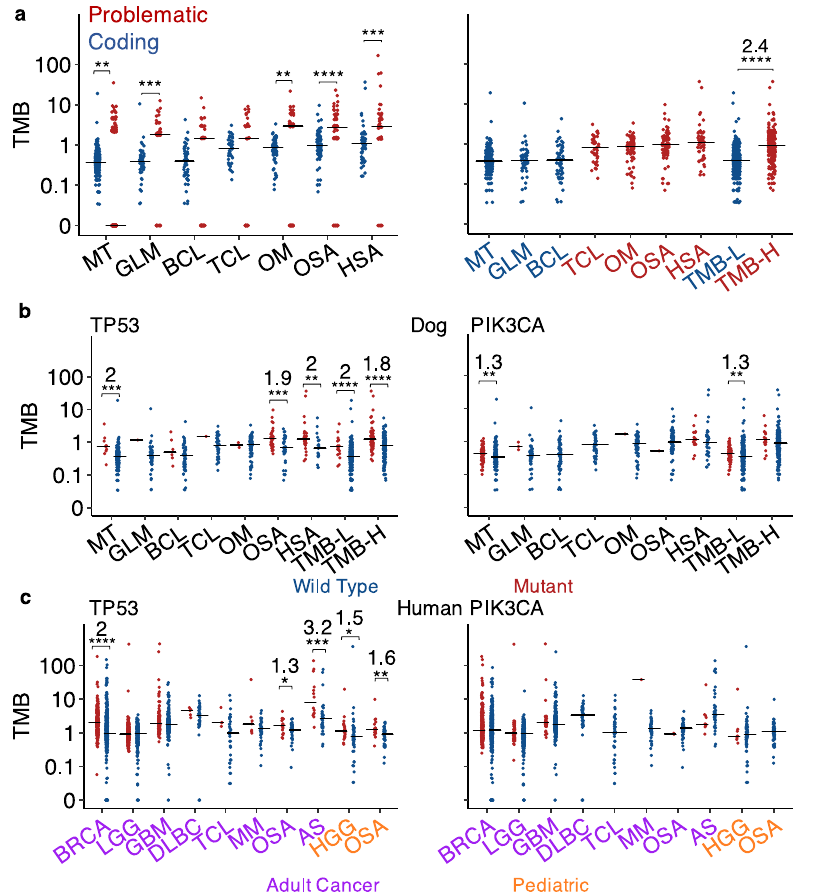
Fig. 6 TMB varies among tumor types and is correlated with TP53 mutation. a TMB distributions of each canine tumor type ordered left to right from lowest to highest median values. The left plot shows that problematic genes (see “ Methods ” ) have signi fi cantly higher TMB than other genes, and thus were excluded from further analyses. The right plot indicates that canine tumors are classi fi ed into TMB-low (TMB-L) and -high (TMB-H). Two-sided Wilcoxon tests were conducted to examine the TMB difference between two groups indicated, with **, ***, **, ****, ***, and **** from left to right representing unadjusted p = 0.006, 0.0006, 0.001, 4.7e − 6, 0.0003 and 2e − 16, respectively. For signi fi cant comparisons, the fold change in median TMB is also indicated. n = 202, 49, 55, 38, 71, 78, 49, 306 and 236 independent tumors for each tumor type listed from left to right, respectively. b , c TMB distributions of cases with wild type (blue) or mutant (red) TP53 or PIK3CA within each canine ( b ) or human ( c ) tumor type. For tumor types with both wild type and mutant groups having ≥ 5 tumors, two-sided Wilcoxon tests were conducted to determine the signi fi cance of the association between TMB and TP53 or PI3KCA , with unadjusted p -values and fold changes shown as described in ( a ). LGG low-grade glioma, GBM glioblastoma, HGG high-grade glioma. From left to right: b n = 11, 191, 1, 49, 6, 49, 1, 37, 2, 69, 40, 38, 29, 20, 18, 288, 72 and 164 independent tumors for TP53 (***, ***, **, ****, and **** representing p = 0.0002, 0.0003, 0.005, 2.4e − 7 and 9.9e − 5, respectively), while n = 74, 128, 3, 46, 55, 38, 1, 70, 1, 77, 15, 34, 77, 229, 17 and 219 independent tumors for PIK3CA (** and ** representing p = 0.005 and 0.007, respectively). c n = 345, 703, 249, 265, 121, 268, 5, 36, 4, 38, 7, 39, 20,